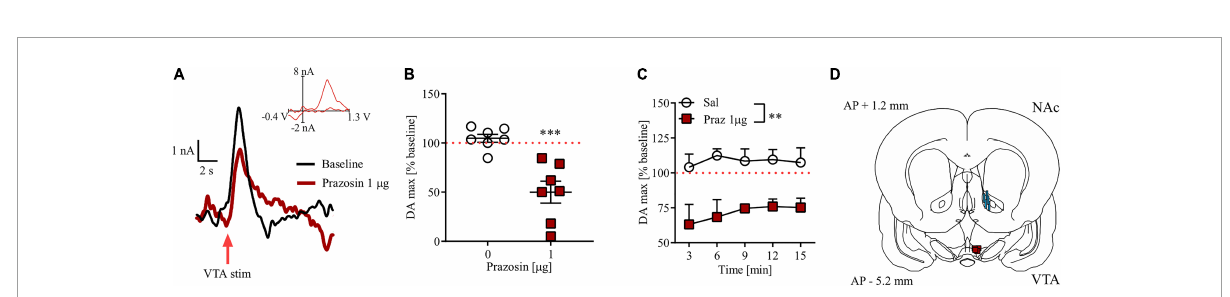
FIGURE4 Localization of α 1 -AR-expressing cells in the anterior parts of the VTA of TH-cre + rats. (A) Representative image of the EYFP- and α α 1 -AR-expressing cells. (B–E) Magnified cells with 1 -AR expression (red), EYFP (green), DAPI (blue), and merged channels showing α 1 -AR-immunoreactive and EYFP-expressing cells (white arrows) in the medial part of the anterior VTA. (F–I) Magnified cells with EYFP (green), DAPI (blue), and merged channels showing co-localized α 1 -AR-positive and EYFP-expressing cells (white arrows) in the lateral part of the anterior VTA. (J–Q) α 1 -AR expression in astrocytes (S100B) and GAD67-positive GABAergic interneurons. (J–M) Magnified images of astrocytes (red), α 1 -AR immunostaining (green), DAPI (blue), and composite images showing co-localization (white arrows) between α 1 -AR and S100B expression. (N–Q) Magnified images of GAD67-positive interneurons (red), α 1 -AR expression (green), DAPI (blue), and composite images showing co-localization between α 1 -AR and GAD67 immunoreactivity (white arrows). PBP, parabrachial pigmented nucleus; RLi, rostral linear nucleus.